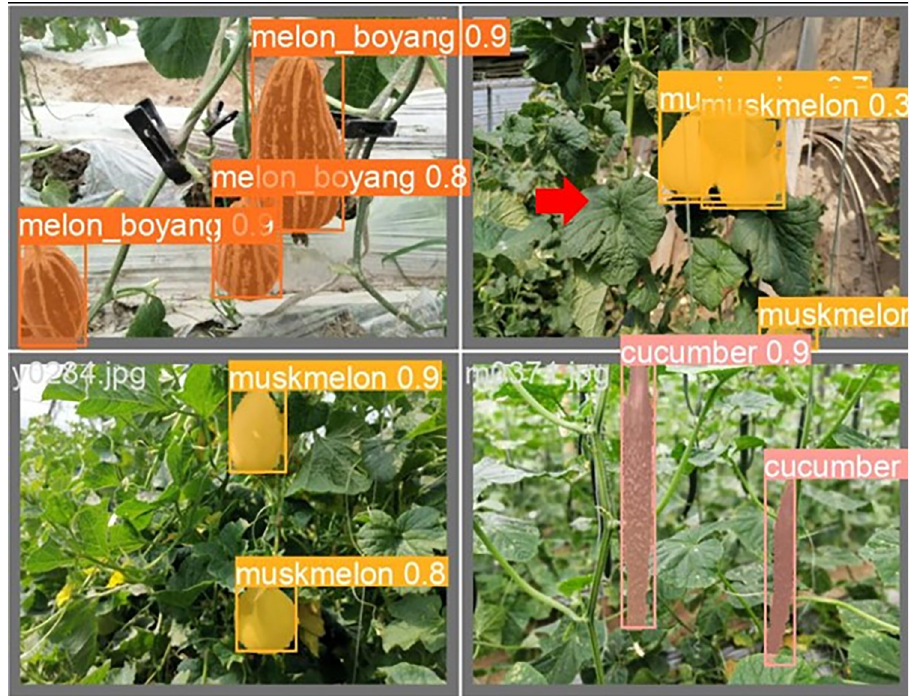
Fig 17. Image results of YOLOv5-LiNetC.